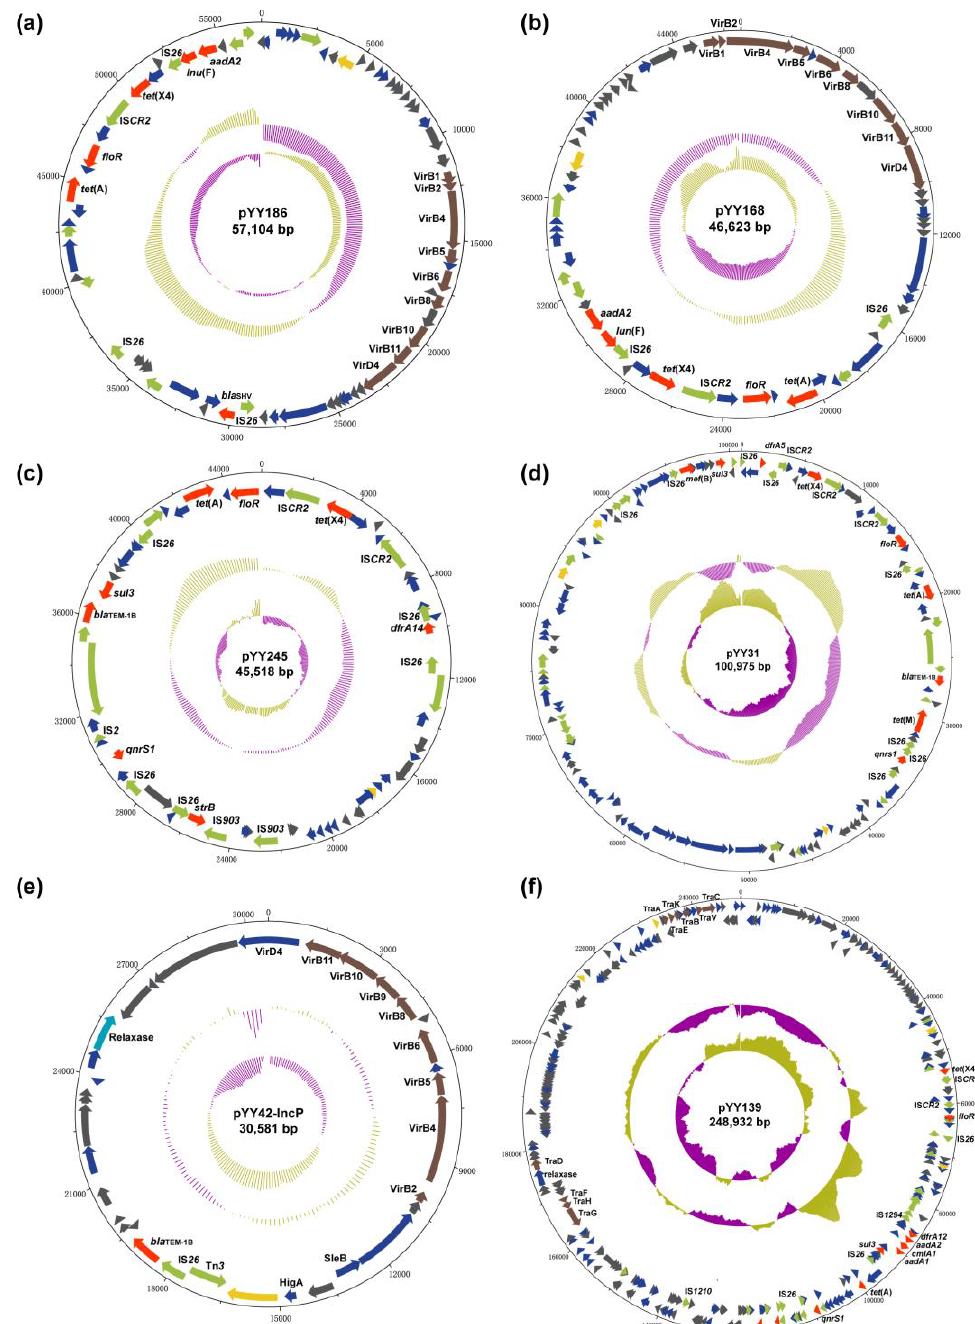
Figure 3. Schematic maps of multiple plasmids. A circular map of pYY186 ( a ), pYY168 ( b ), pYY245 ( c ), pYY31 ( d ), pYY42-IncP ( e ), and pYY139 ( f ). The innermost circle presents the GC-Skew and the middle circle presents the GC content. The gene functions are indicated by arrows with different colors in the outer circle. Red, AMR gene; yellow, replication initiation protein gene; brown, conjugative transfer gene; green, mobile element; dark grey, hypothetical protein gene; navy blue, other functional gene.